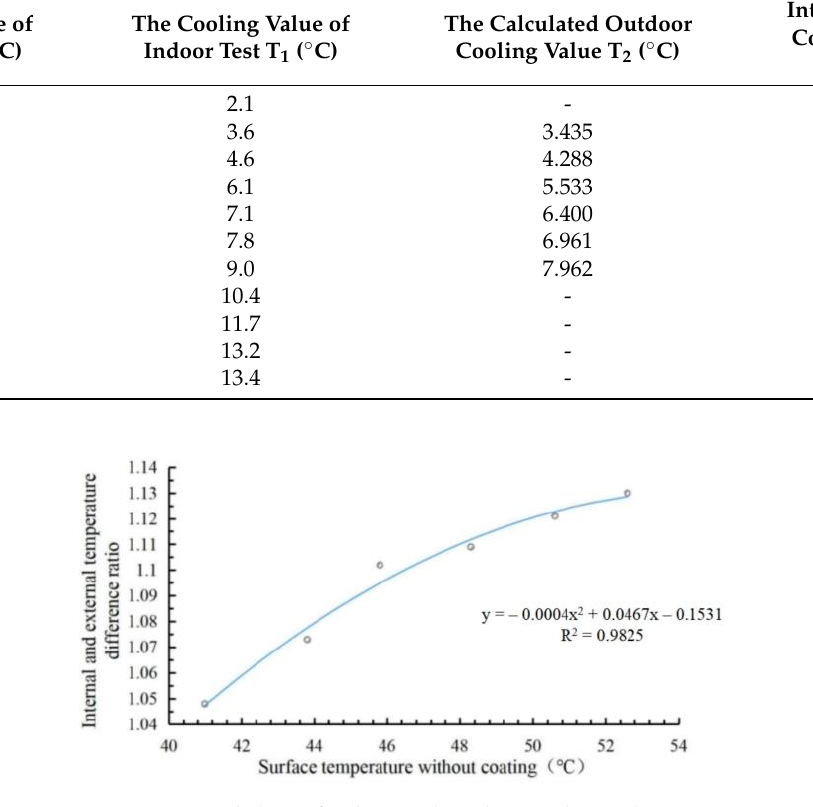
Table 8. Indoor and outdoor cooling value ratio at the same temperature.